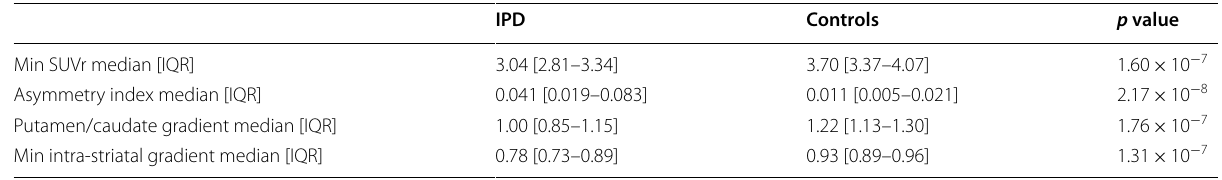
All ratios are unitless and expressed as median with interquartile range